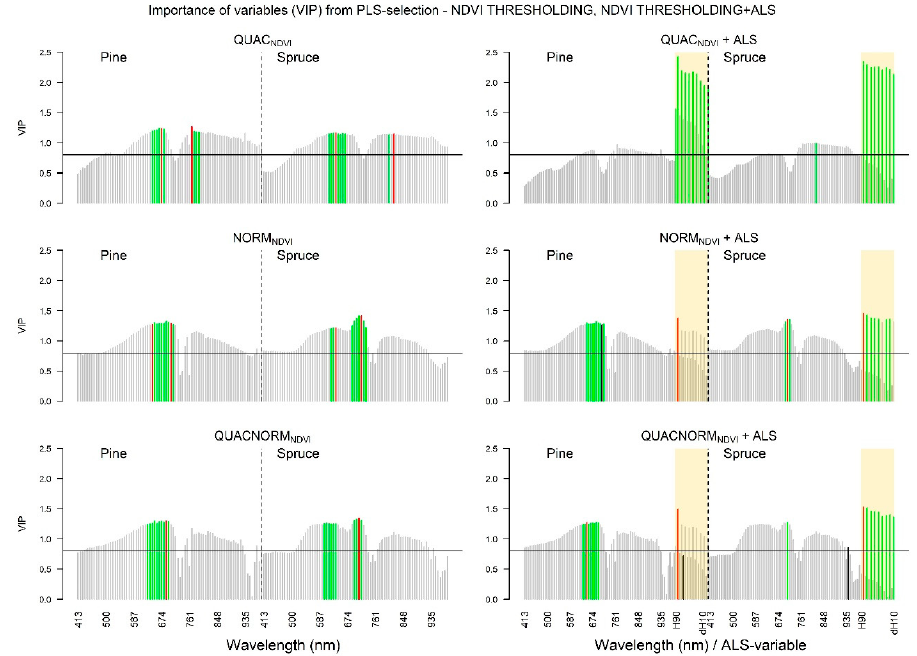
Figure 2. Variable importance for projection (VIP) values from the partial least squares (PLS) analysis with site index as a response for hyperspectral variables, and hyperspectral variables in combination with ALS variables. In each panel, results for pine appear on the left, and results for spruce appear on the right. The 10 top-ranking variables according to VIP appear in green. Variables among the top-ranking variables that were included in the subsequent modelling appear in red. Black bars indicate variables that were selected in the modelling, but that were not among the top 10. The results in each panel show variables derived from hyperspectral data where pixels were selected with a NDVI threshold but with different preprocessing; upper left: atmospherically corrected hyperspectral data; middle left: normalized hyperspectral data; lower left: atmospherically corrected and normalized hyperspectral data; upper right: atmospherically corrected hyperspectral data with ALS variables; middle right: normalized hyperspectral data with ALS variables; lower right: atmospherically corrected and normalized hyperspectral data with ALS variables. In the right column of the panels, the bars representing the ALS variables appear on a yellow background. The sequence of ALS variables from left to right is H90 1999 , dH90, H80 1999 , dH80, ... , H10 1999 , and